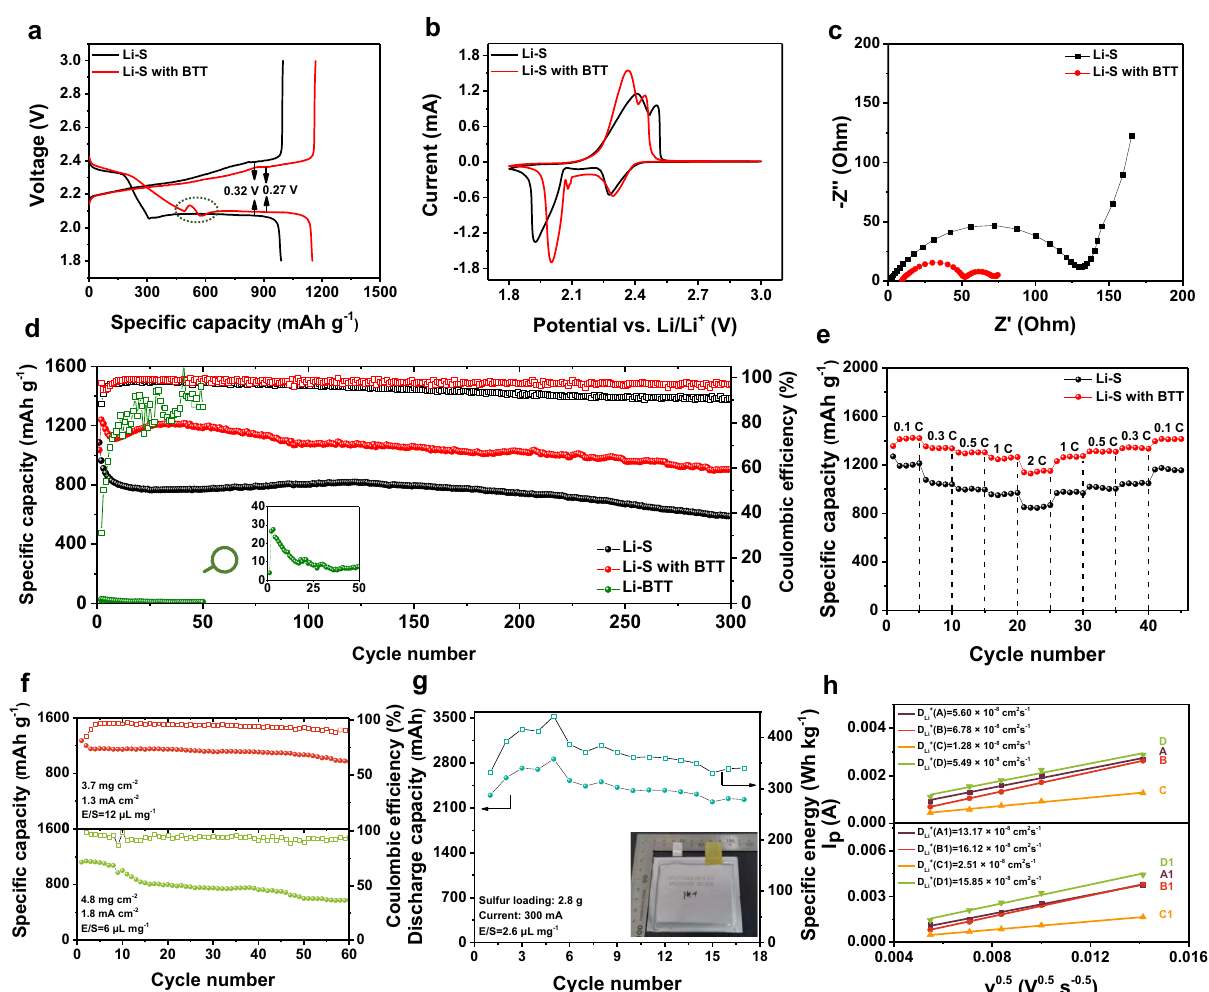
Fig. 1 Electrochemical performance of Li-S cells with BTT and blank electrolyte. a The 5 th (stable cycle) galvanostatic charge/discharge pro fi le of Li-S cells with and without BTT at 0.2C rate. b Cyclic voltammograms (CV) scans of the two types of cells at 0.05 mV s − 1 . c Nyquist plots of the two types of cells before cycling. d Long-cycling performance and Coulombic ef fi ciency of the Li-S cells with and without BTT at 1C rate for 300 cycles. e The different C-rate performance of two types of cells at 0.1C, 0.3C, 0.5C, 1C, and 2C rates and then back to the low C rate. f Cycling performance of two BTT cells at 0.2C rate with high sulfur loadings of 3.7 and 4.8 mg cm − 2 and E/S ratios of 12 and 6 µ L mg − 1 , respectively. g Cycling performance of a BTT pouch cell with total sulfur mass of 2.8 g and E/S ratio of 2.6 µ L mg − 1 . The current is 300 mA. The speci fi c energies are based on the masses of electrodes (lithium metal anode and sulfur cathode) and electrolyte. The inset photograph shows the front image and dimensions of the pouch cell. h Linear fi ts of the peak currents and the Li + diffusion coef fi cient calculated by the Randles-Sevcik equation for Li-S cells with and without